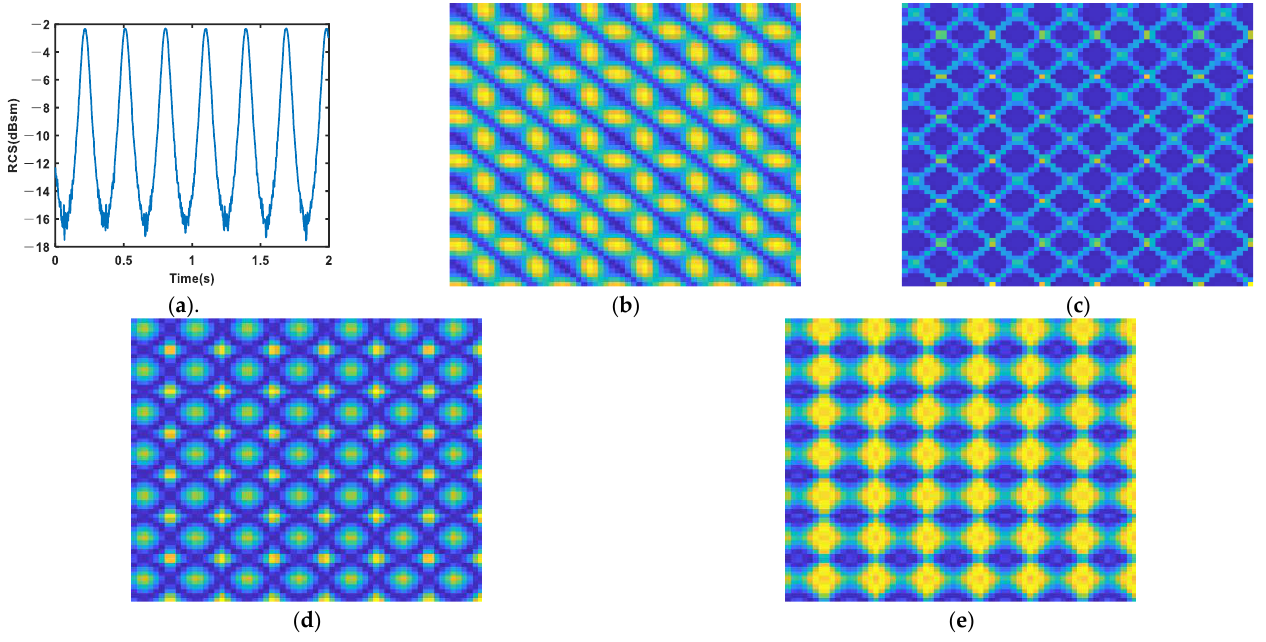
Figure 5. ( a ) RCS; ( b ) RP; ( c ) MTF; ( d ) GASF; ( e ) GADF . RCS sequences encoding of the heavy decoy.